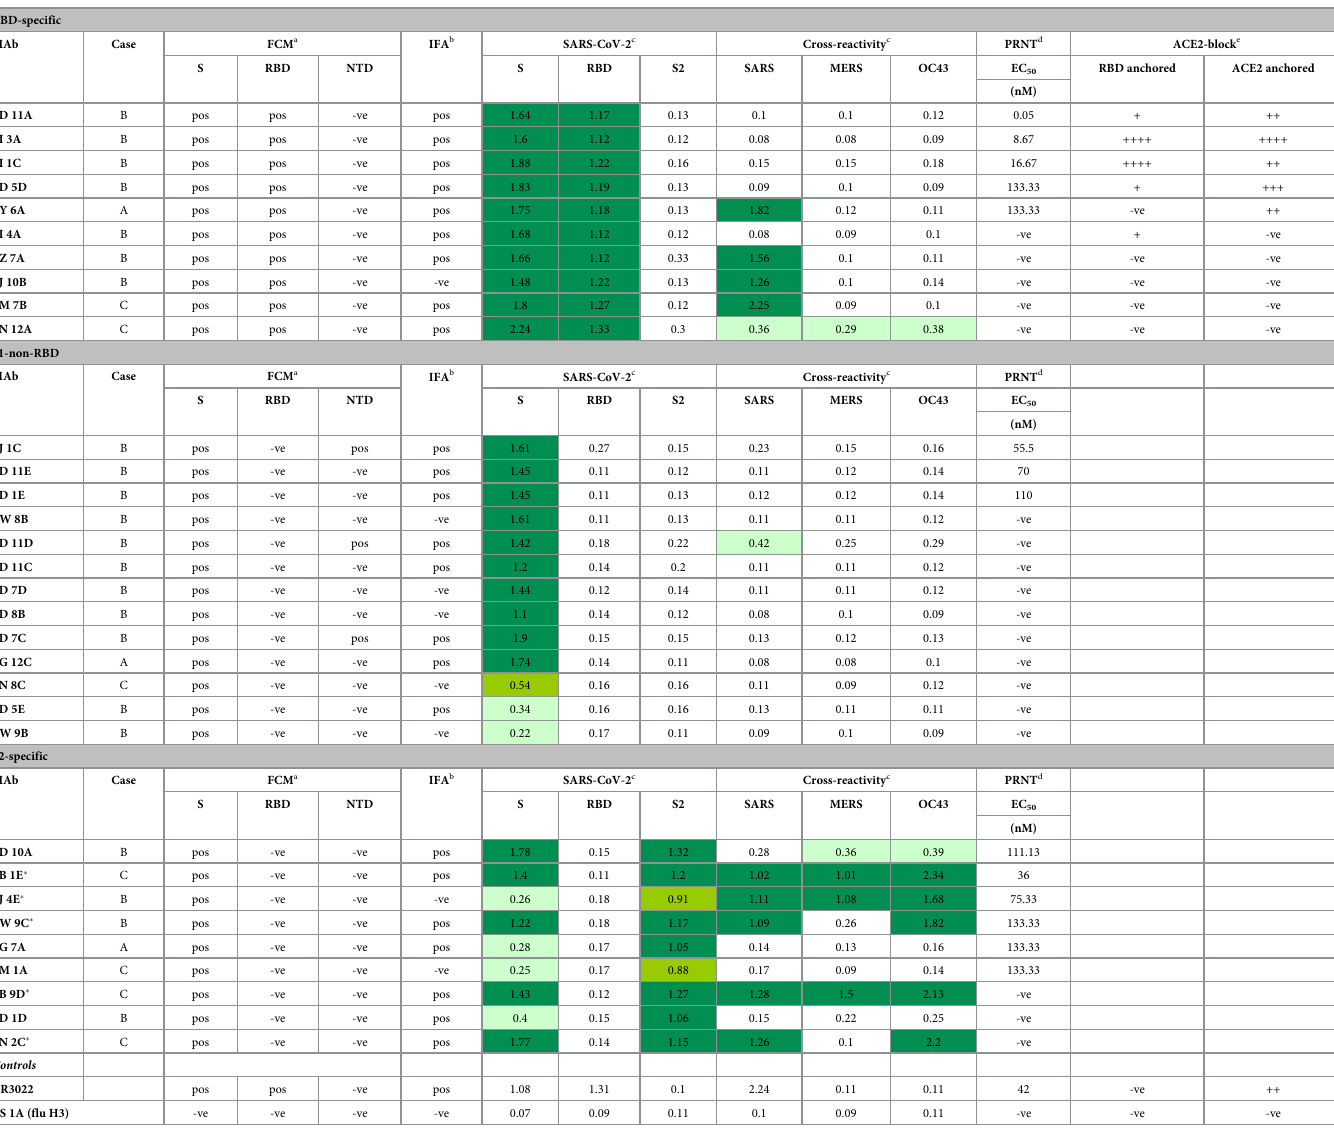
Table 1. The antigenic specificity, cross-reactivity and function of 32 anti-SARS-CoV-2 spike monoclonal antibodies derived from COVID-19 patients. RBD-specific MAb